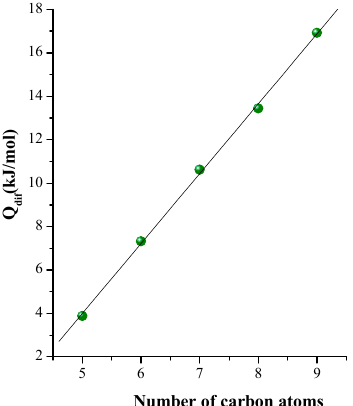
Figure 9. Dependence of differential adsorption heats (Q d ) on the number of carbon atoms C5–C9 in the n -paraffins.